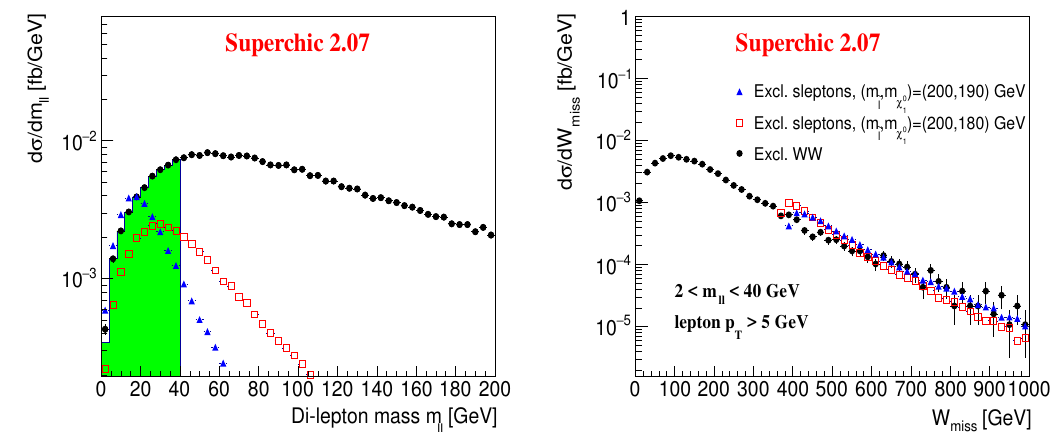
Figure 1 . Distribution of di-lepton mass (left) and missing mass W miss (right) for exclusive slepton pair and WW production. The di-lepton distribution was obtained before applying any cuts and the green area indicates the acceptance region used in the analysis. The W miss distribution was obtained after applying lepton p T and di-lepton mass cuts, see table 2. W miss > X lepton p T interval [GeV] [GeV] 5{15